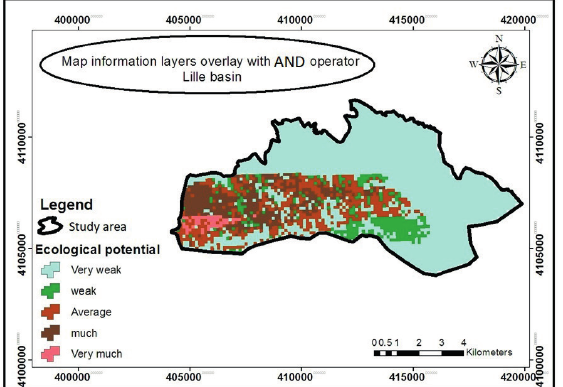
Figure 4 - Overlay map of the information layers using Gamma operator.